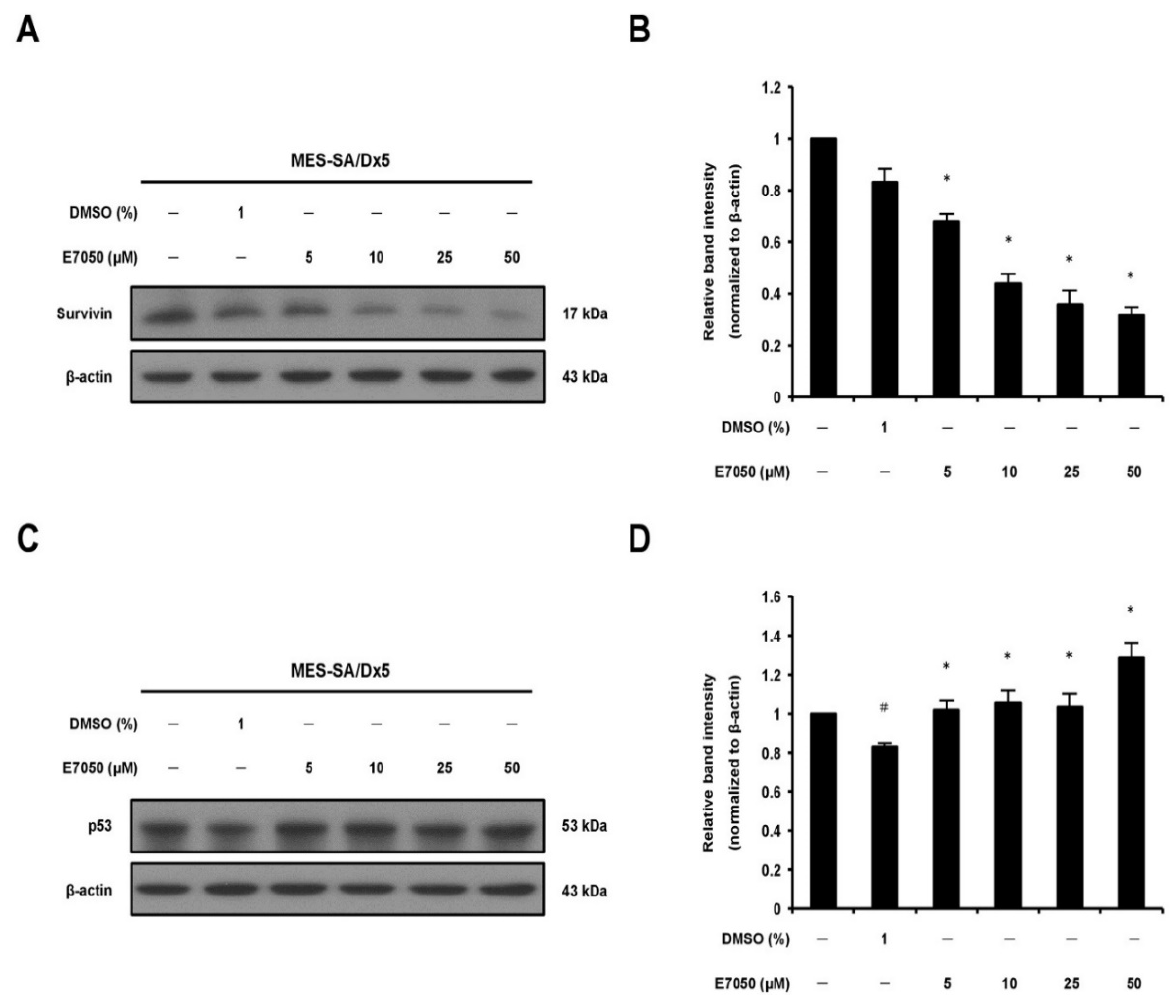
Figure 3. Effects of E7050 on the expression of survivin and p53 proteins in MES-SA/Dx5 cells. ( A ) Cells were treated with E7050 at various concentrations (5–50 µ M) for 6 h; thereafter, survivin protein expression level was measured by Western blot analysis. β -actin was used as an internal loading control. ( B ) The relative protein level of survivin was quantified by densitometry and normalized to β‐ actin. ( C ) Cells were treated for 24 h with different concentrations of E7050, and Western blot ‐ ting was performed to assess p53 protein expression. ( D ) The relative protein level of p53 was quan ‐ tified by densitometry and normalized to β‐ actin. Data are presented as the mean ± SEM of three independent experiments. # p < 0.05 versus untreated cells. * p < 0.05 versus vehicle ‐ treated control cells.